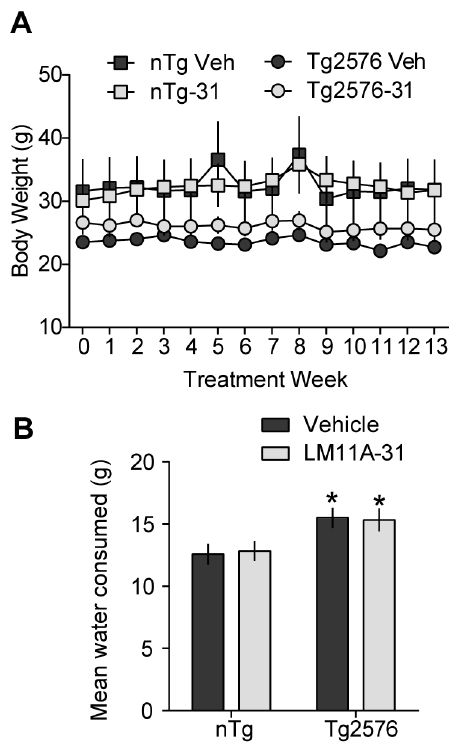
Figure 3. Body weight and water consumption are not affected by LM11A-31 treatment in Tg2576 mice. ( A ) Body weight of 17 month old female Tg2576 mice treated with LM11A-31 for 3 months (nTg-Veh, n=7 mice; Tg2576-Veh, n=6; Tg2576-31, n=5; nTg–LM11A- 31, n=4). Starting at treatment week 6, Tg2576 mice weighed less than WT mice; LM11A-31 had no effect on this measure. Statistical significance was determined using repeated measures ANOVA with Dunnett’s post-hoc test. ( B ) Average grams of water consumed by Tg2576 mice over 3 days was significantly greater than nTg mice; LM11A-31 had no effect on this measure. Statistical significance was determined using two-tailed Student’s t-test. *p # 0.05 vs. nTg Veh.